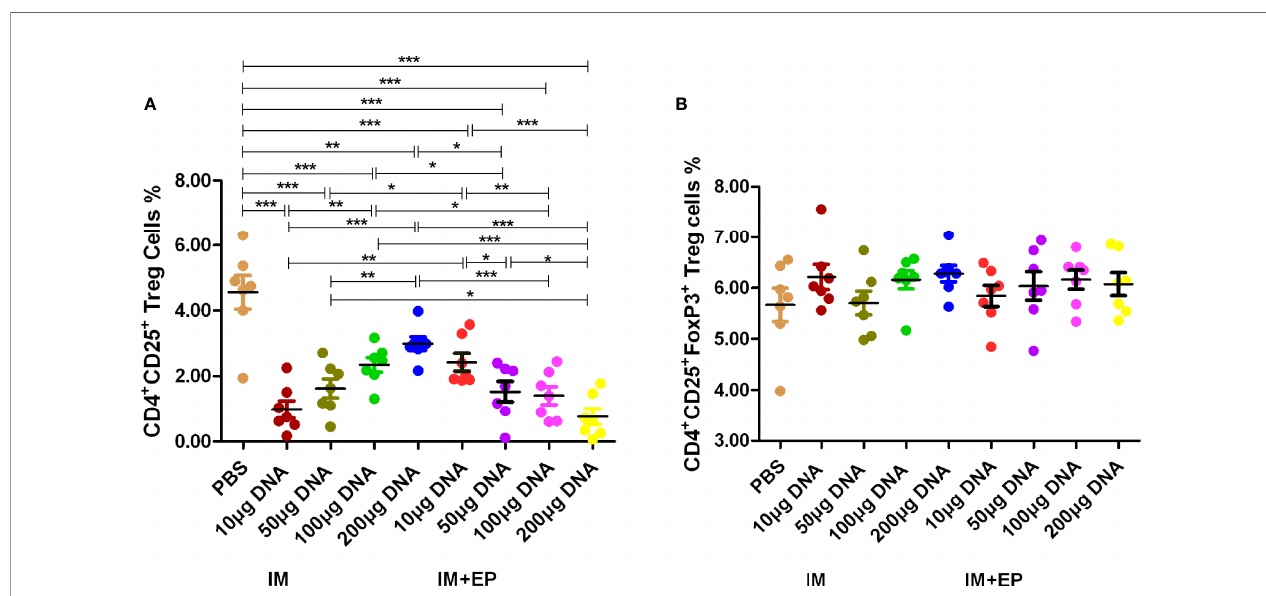
FIGURE 3 | Frequencies of CD4 + and CD25 + Treg cell subsets in whole blood were assessed by fl ow cytometry. At 17-18 days after the third immunization, the data are expressed as the mean% ± standard deviation (n = 7) from 7 mice in each group. (A) Frequencies of CD4 + CD25 + Treg cells; (B) Frequencies of CD4 + CD25 + Foxp3 + Treg cells. IM, intramuscular injection; EP, electroporation. * P < 0.05, ** P < 0.01, ***P <